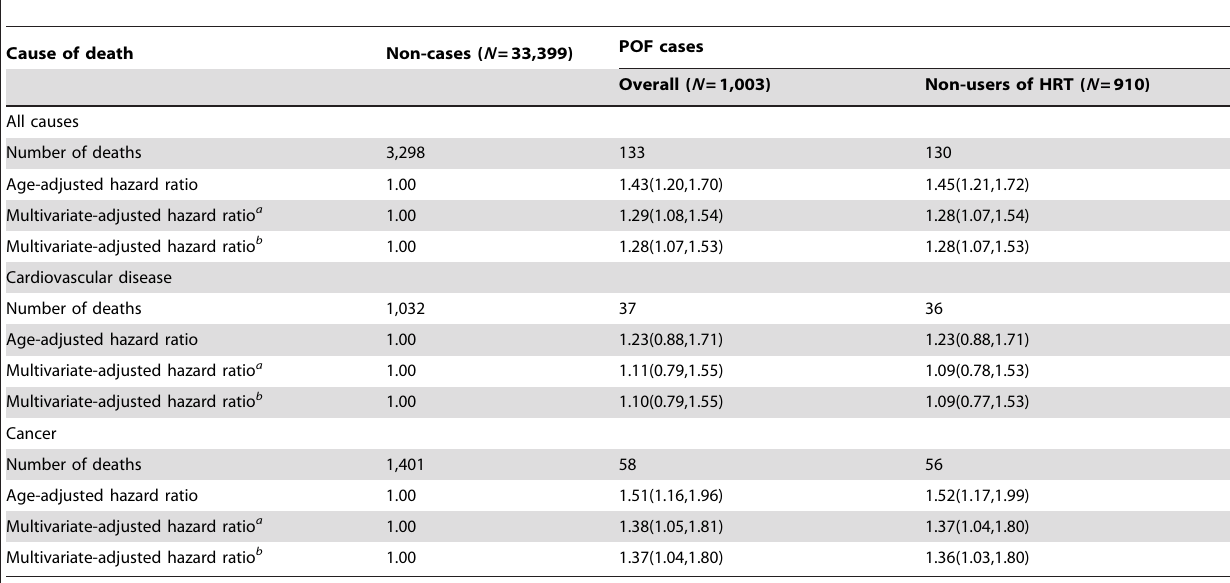
Table 3. Adjusted HRs and 95%CIs for all-cause and cause-specific mortality in POF cases.